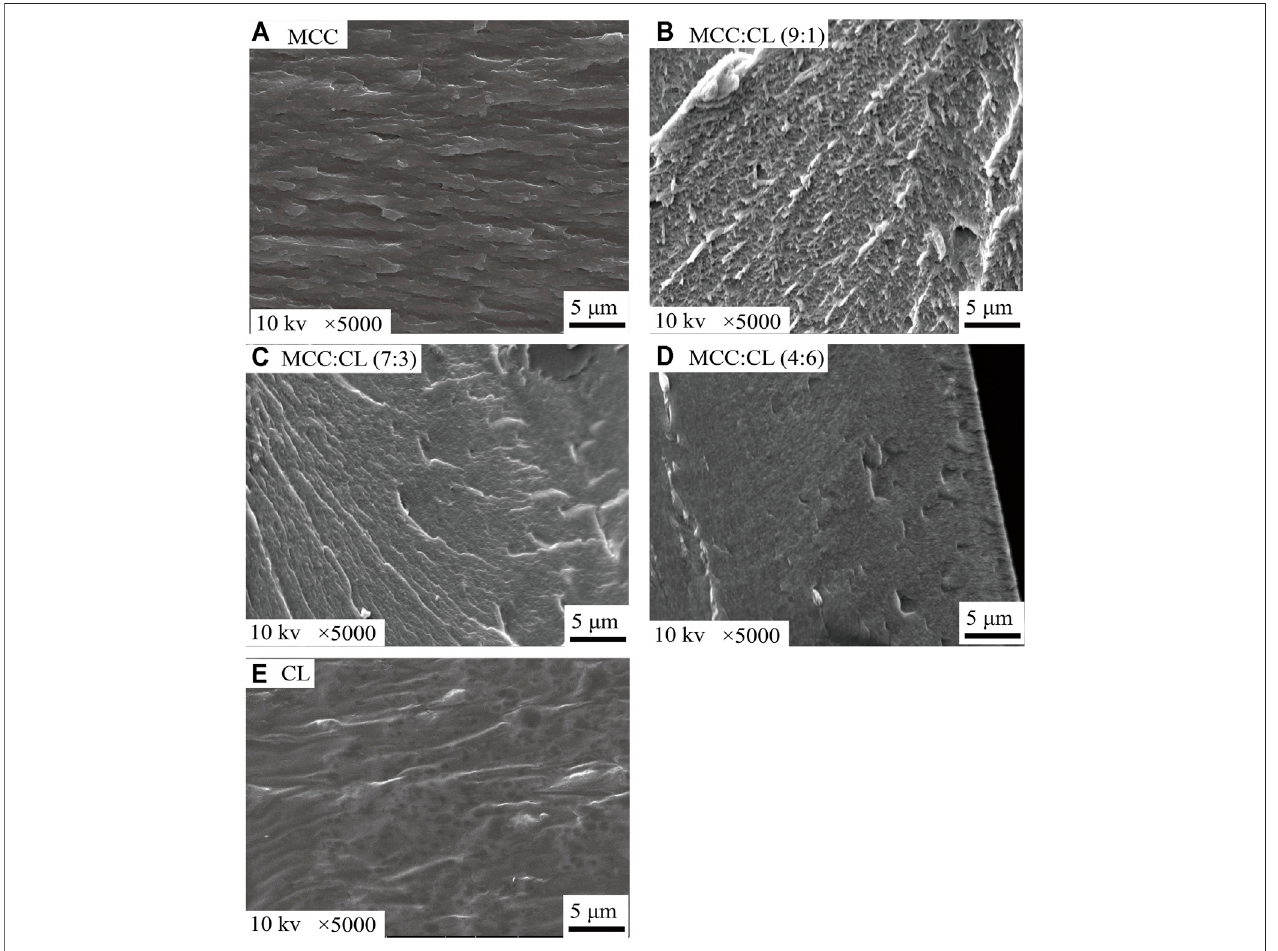
FIGURE 3 | SEM images of fractured cross sections of the MCC fi lm (A) , MCC:CL (9:1) fi lm (B) , MCC:CL (7:3) fi lm (C) , MCC:CL (4:6) fi lm (D) , and CL extract (E) .